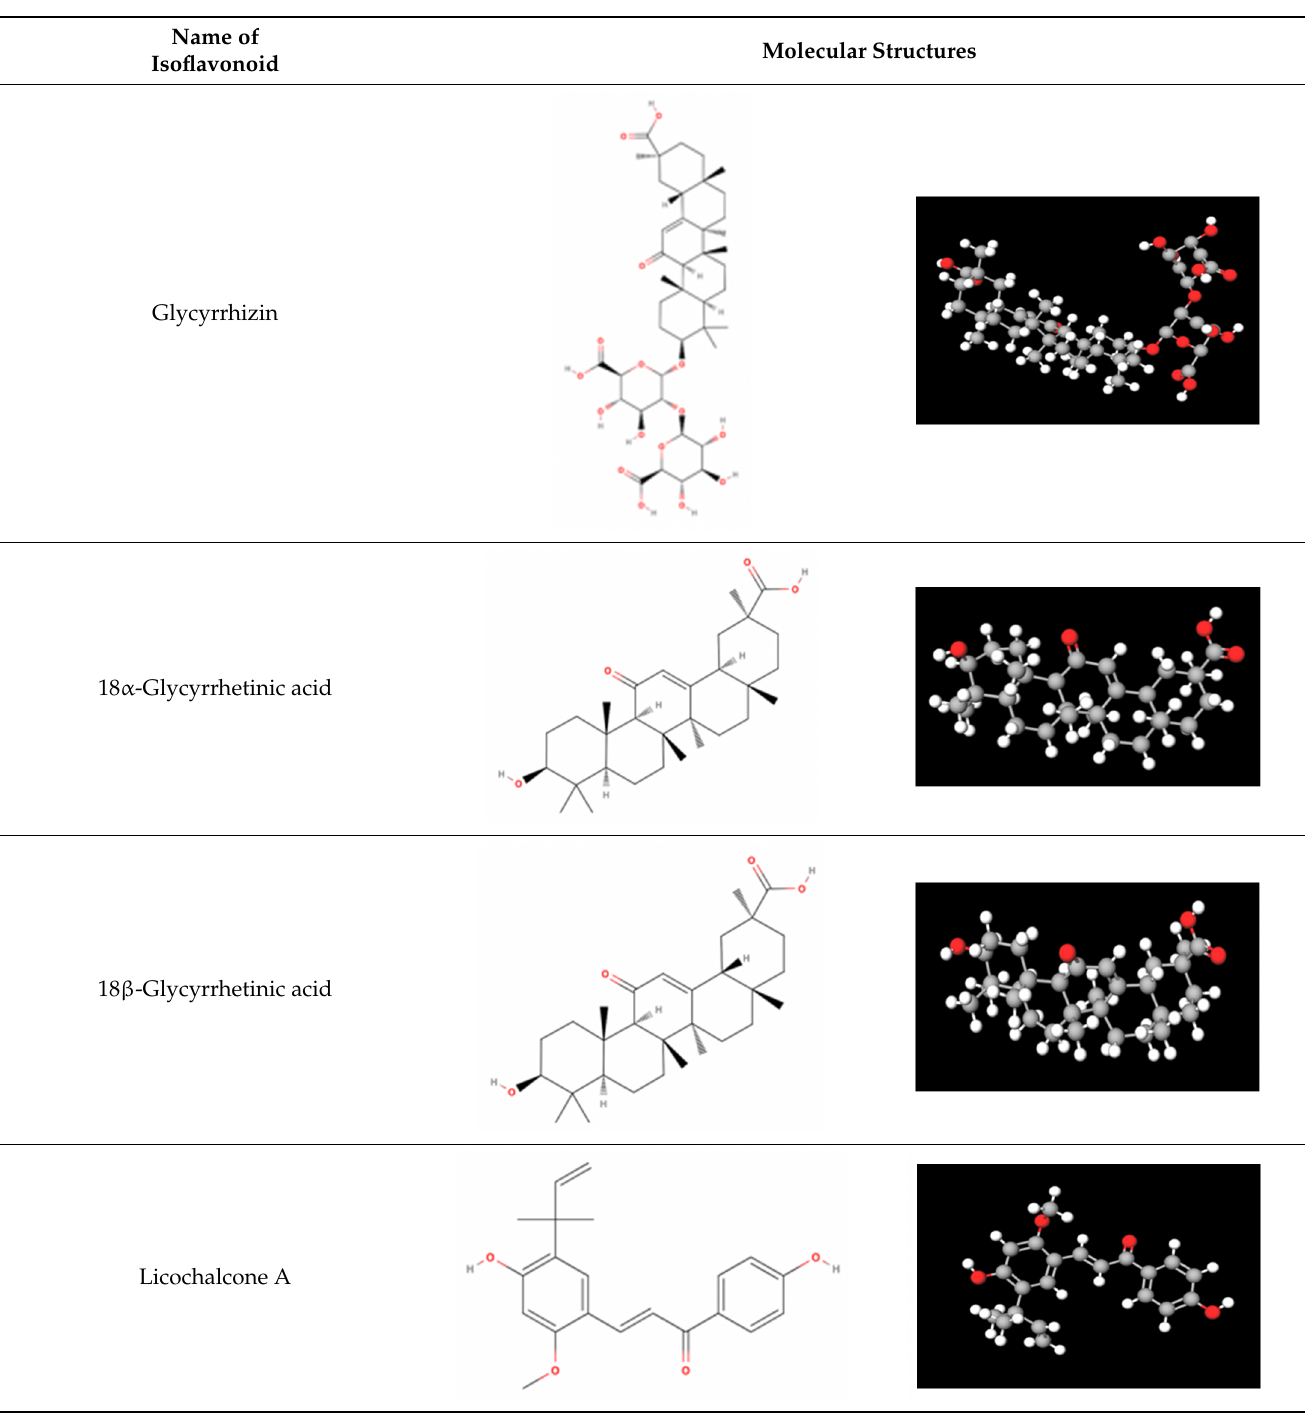
Table 2. The 2D and 3D structures of major isoflavonoids in licorice (derived from the MolView software version 2.4).